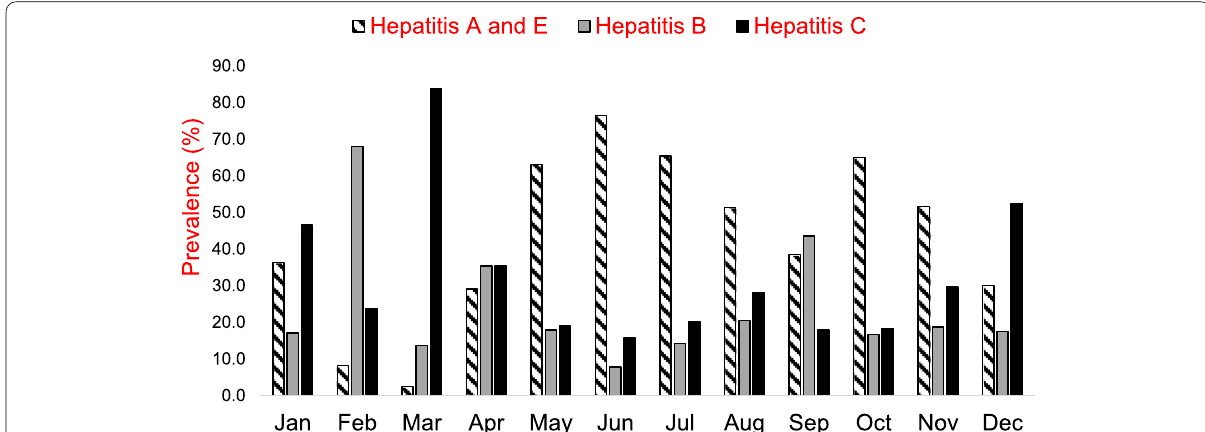
Fig. 3 Monthly comparative (relative) percentage prevalence of different types of viral hepatitis in indoor patients based on the pooled data in the District Dera Ismail Khan during